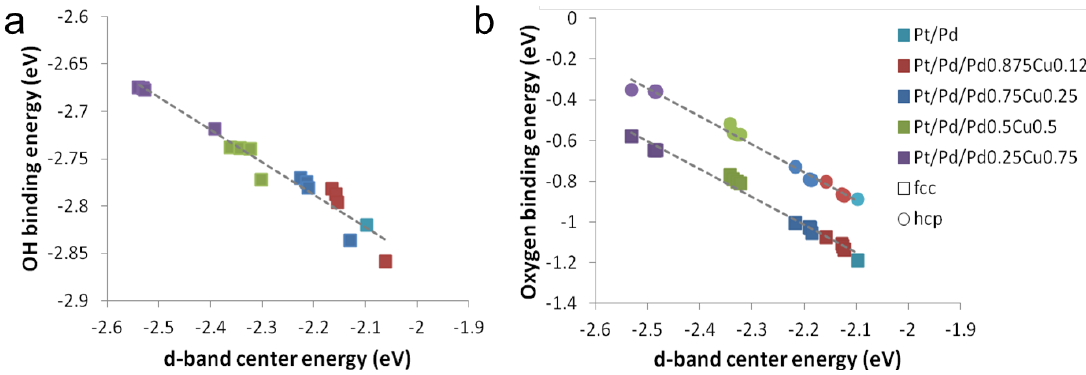
Figure 5. The correlation between surface binding strength and position of the d-band center for oxygen reduction reaction (ORR) intermediates: ( a ) OH species on the top sites and ( b ) oxygen atoms on fcc and hcp hollow